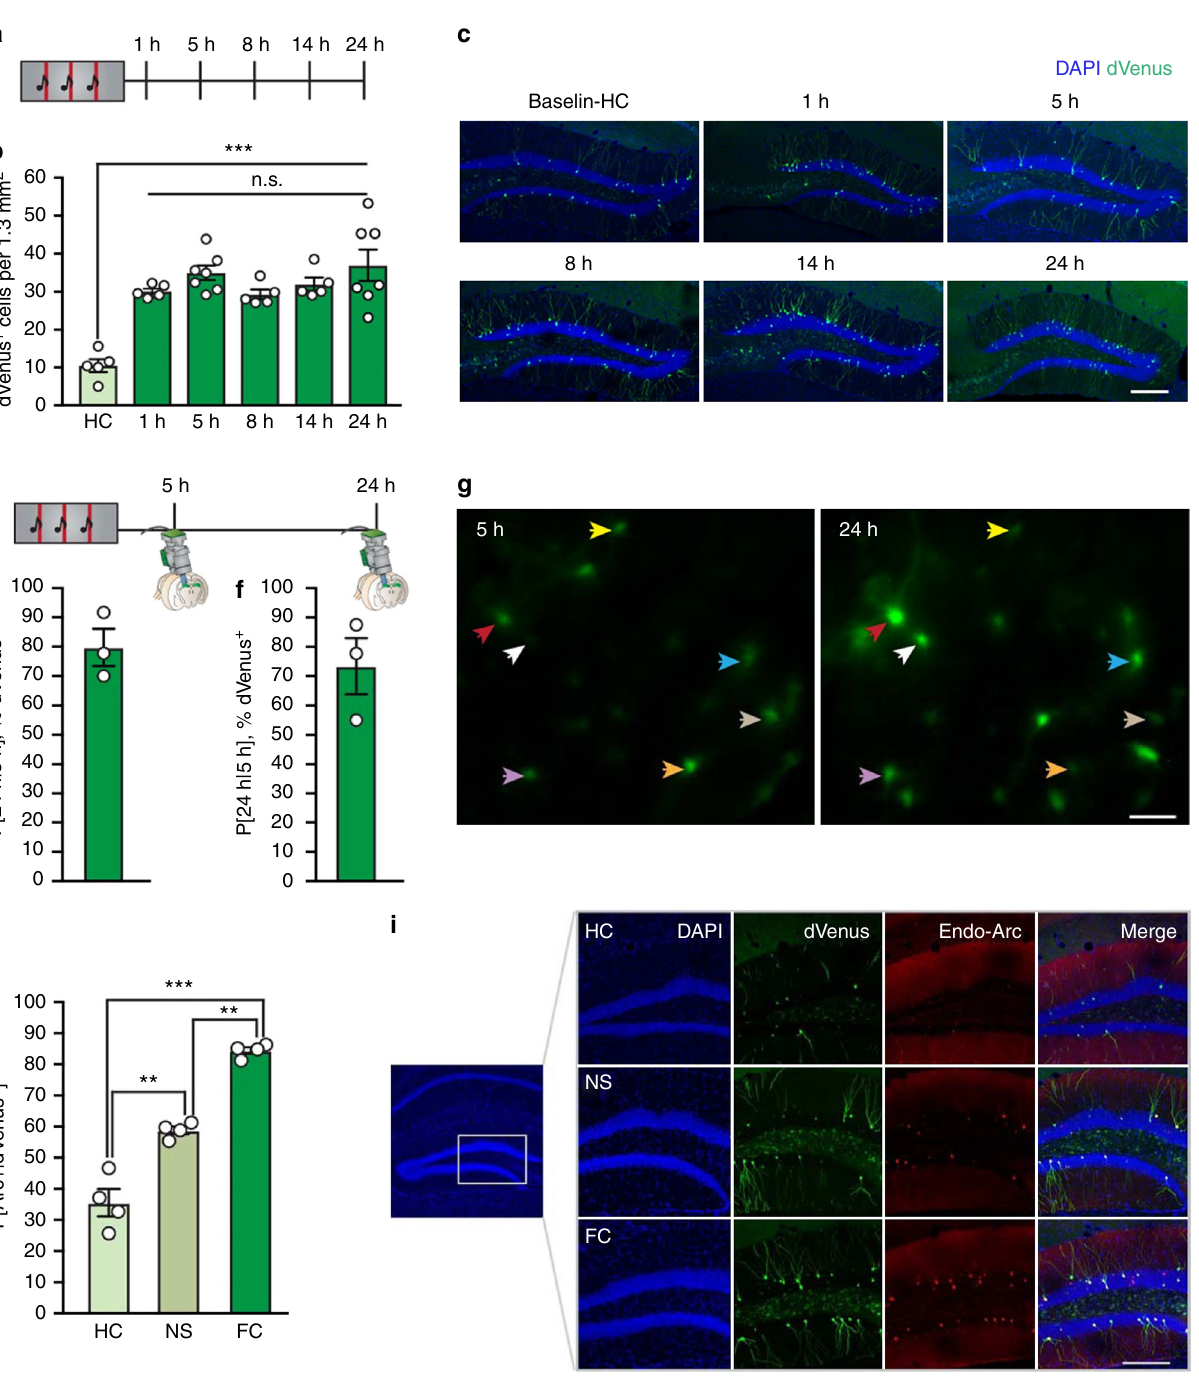
Fig. 1 Activity-dependent, sustained expression of Arc ::dVenus in DG granule cells. a Experimental setup. Arc ::dVenus mice were fear conditioned and the number of dVenus + cells was measured in the DG at successive time-points; 1 h ( n = 5), 5 h ( n = 7), 8 h ( n = 5), 14h ( n = 5) and 24h ( n = 7), after training. Home-cage (HC) controls ( n = 5) serve as a baseline. b Number of dVenus + cells per 1.3mm 2 section in the DG, at speci fi c time-points after